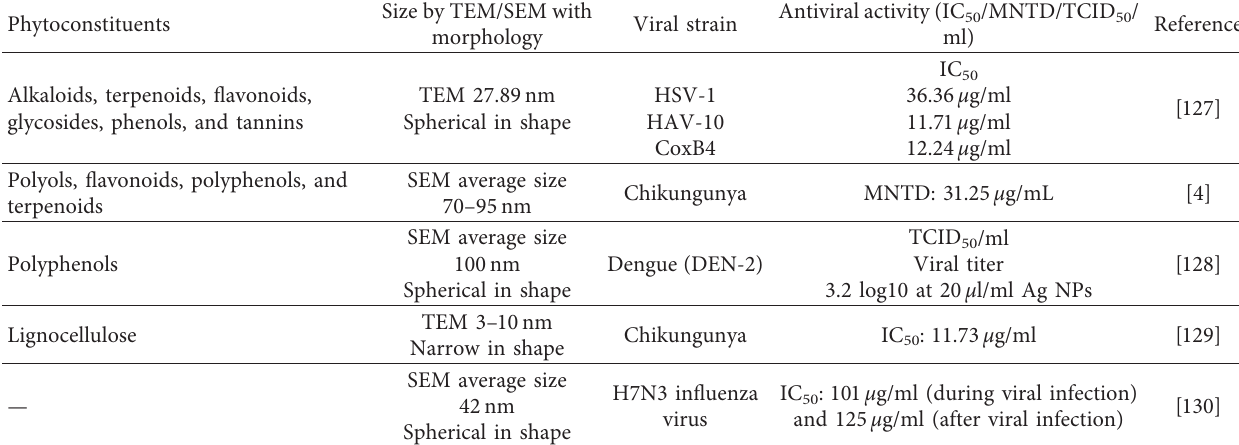
Table 2: Morphology of green synthesized Ag NPs and their antiviral activity on different viral